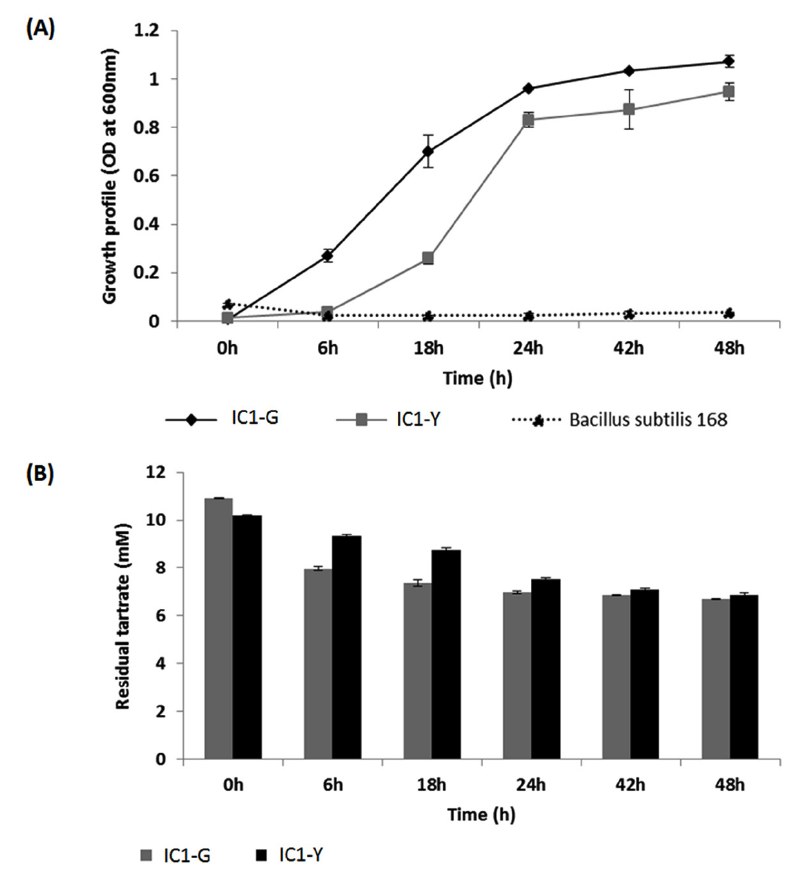
Fig. 2. Aerobic growth and L-tartrate utilization profile of selected isolates as compared to standard strain Bacillus subtilis 168 (A) Growth profile on M9 minimal medium containing L-tartrate as sole carbon source and (B) Residual tartrate levels as monitored in 48 h old culture supernatants. Results are depicted as mean ± SD of 3-4 independent